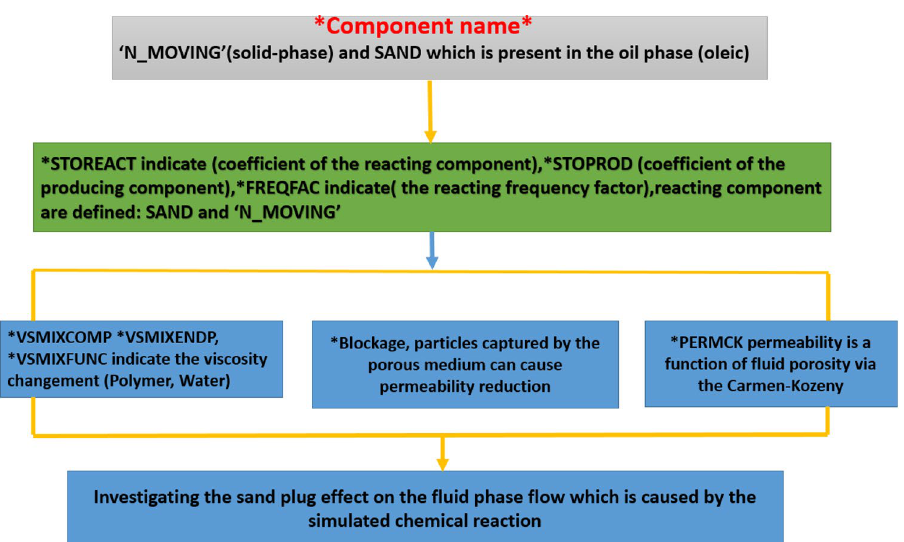
Figure 3. Keyword description of the Polymer sand plug model CMG STARS 2017.10 URL: https:// www. cmgl.